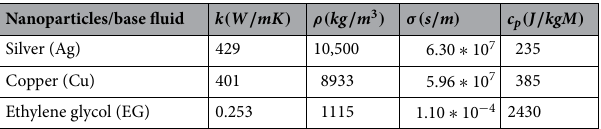
Table 1. Transport characteristics of base fluid and nanoparticles 22,23 .